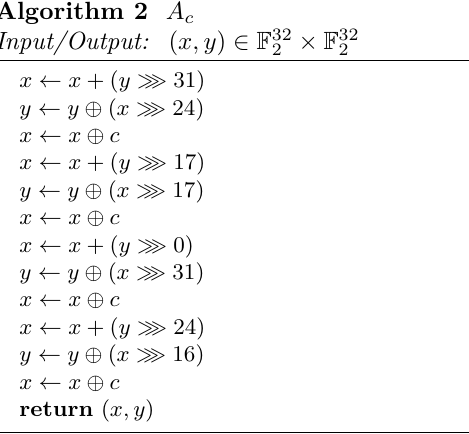
Figure 2: The Alzette instance 𝐴